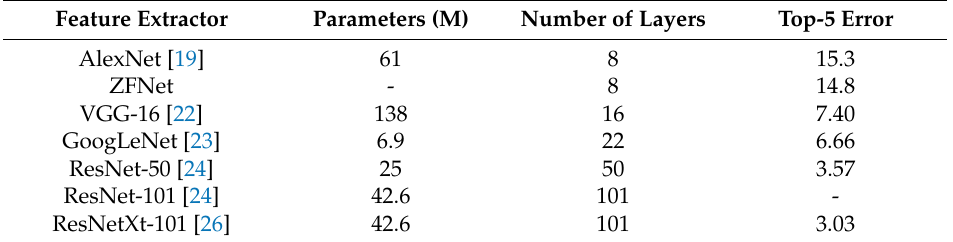
Table 1. Properties of the deep feature extractors used in this work and their performance on the ImageNet Challenge.